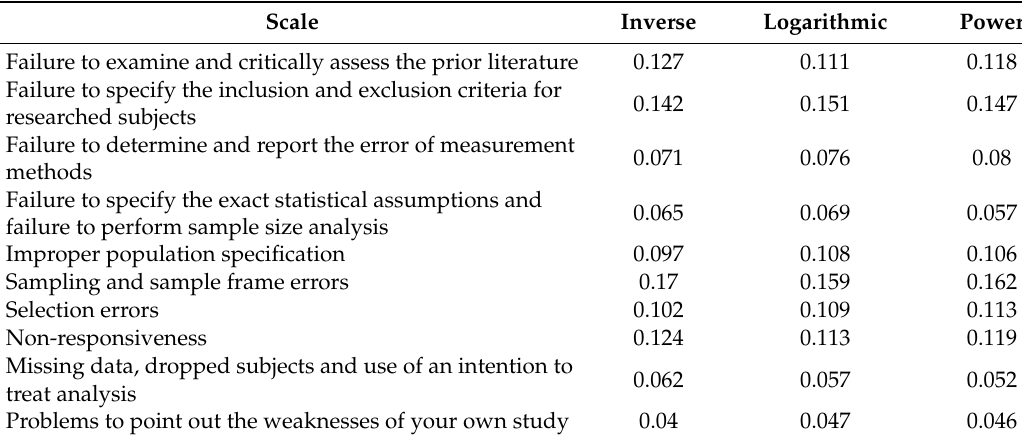
Table 2. Values of obtained eigenvectors of bias influencing factors.